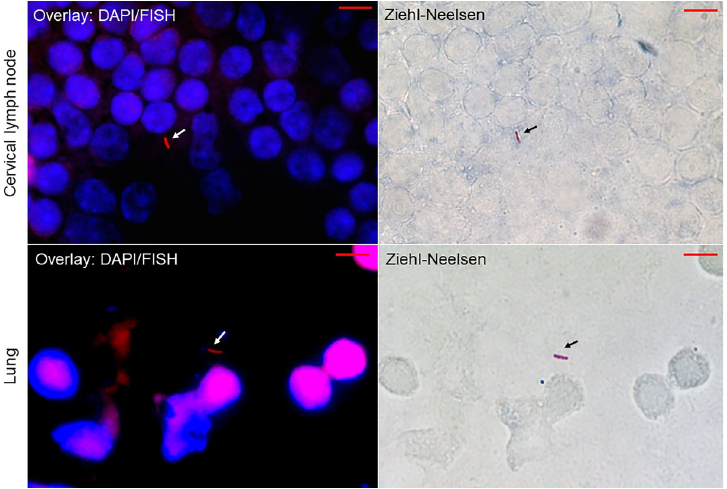
Fig 2. Microscopic images of imprint slides prepared from lung and cervical lymph nodes of Mycobacterium tuberculosis -infected mice at day 28 post-infection with combined FISH, DAPI and Ziehl-Neelsen staining. For fluorescent in situ hybridization (FISH), the slides were observed using a red channel of a Leica DMI6000 microscope under a 100 X oil-immersion objective. The images were captured in the same microscopic field using a Hamamatsu Orca AG camera (Hamamatsu Photonics, Herrsching-am-Ammersee, Germany) for FISH-positive mycobacteria (left images, white arrows) and a DFC425 C Digital Microscope Camera (Leica Microsystemes, Nanterre, France) for Ziehl- Neelsen-positive mycobacteria (right images, black arrows). Scale bar = 5 μ m.